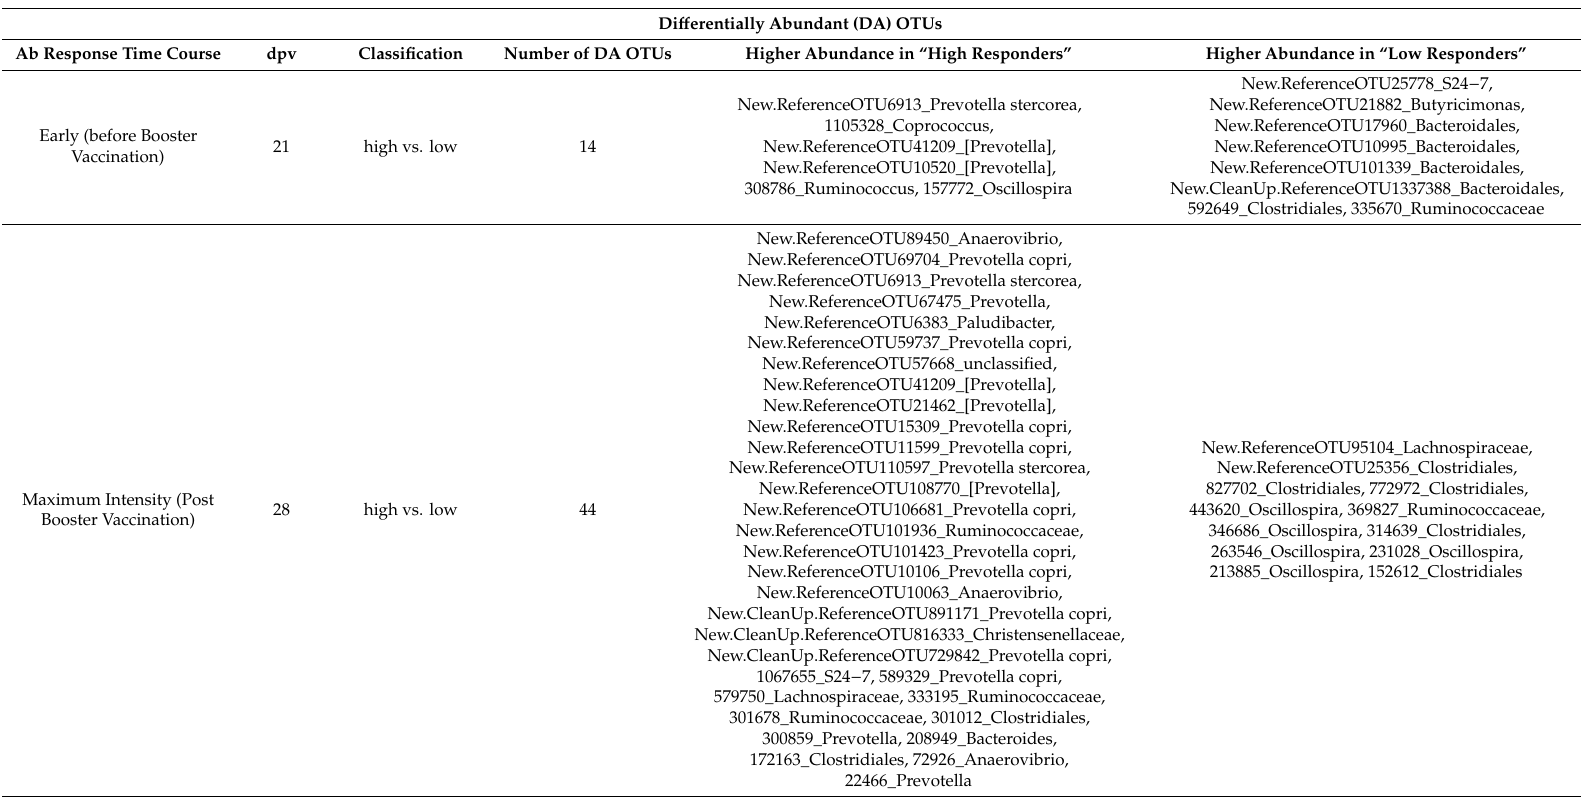
Table 1. Di ff erentially abundant (DA) OTUs between groups of pigs showing contrasted responses (High vs. Low response) to M. hyo vaccination. dpv; days post